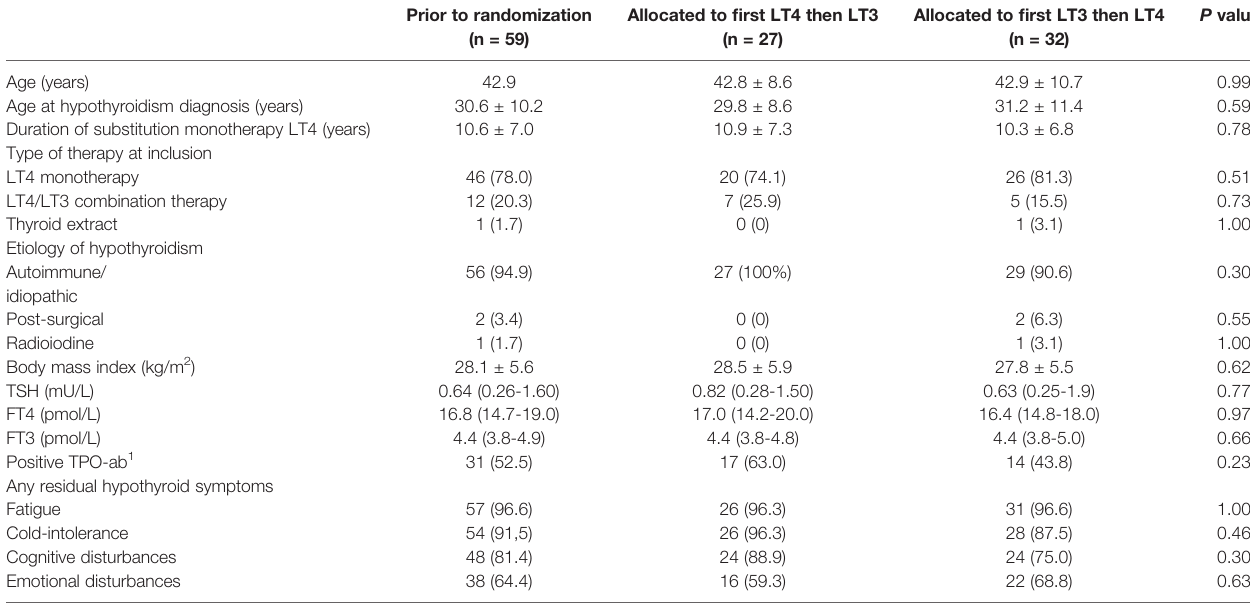
TABLE 1 | Baseline characteristics.